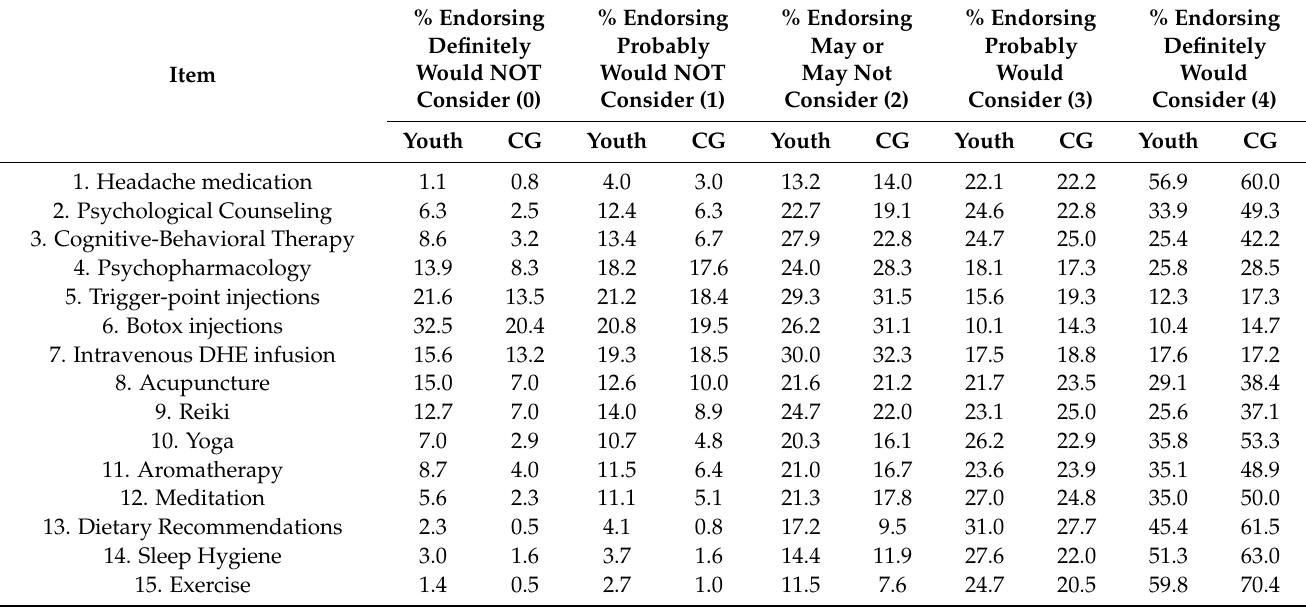
Table 3. Youth/Caregiver Openness to Individual Headache